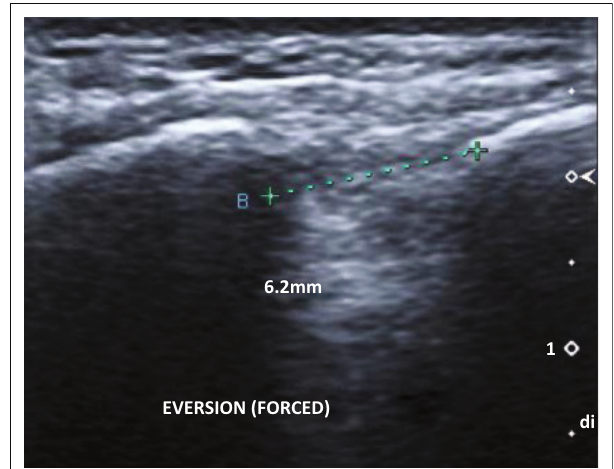
FIGURE 6: Distal tibiofibular clear space measurement (A) with the foot in a neutral position (5.2